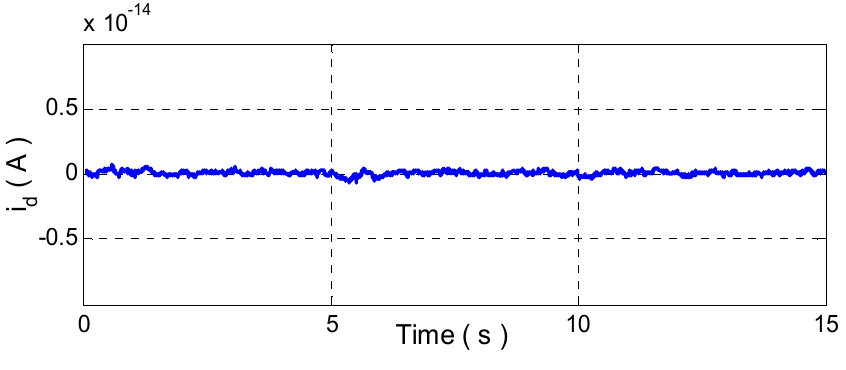
Figure 14. Current i d .